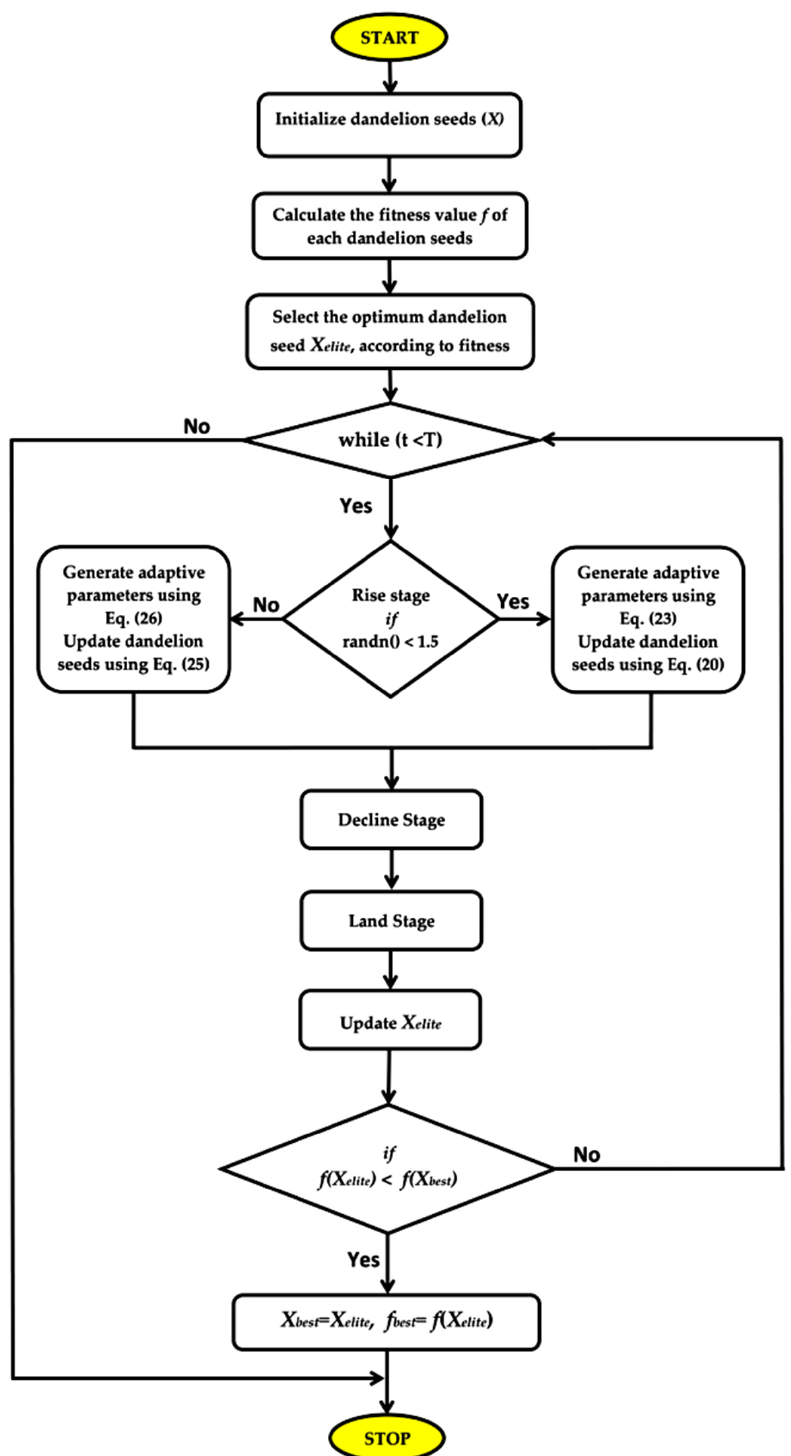
Figure 4. Flow chart of a dandelion optimizer.